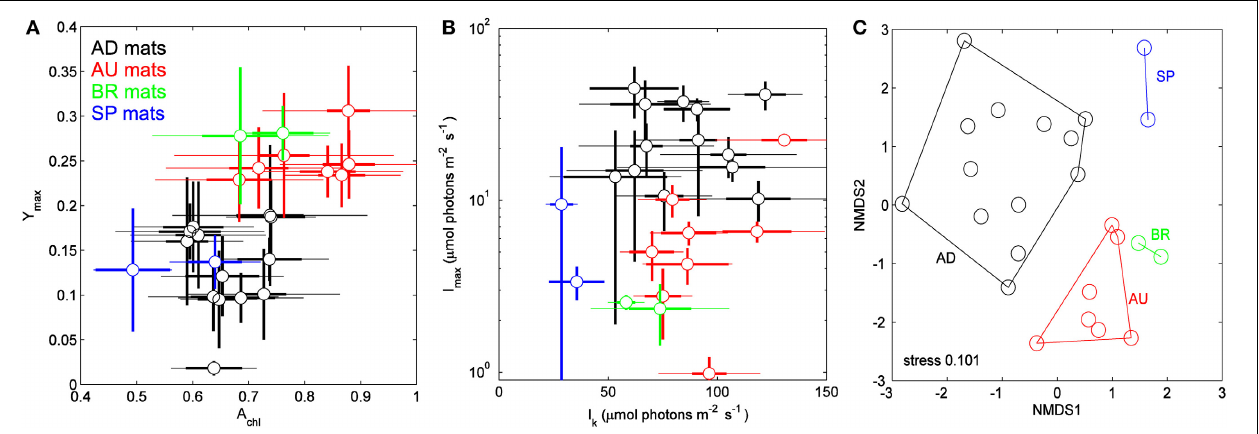
variability (expressed as standard deviation, SD) within the layers, respectively. (C) Multidimensionalscalingplotofthedistancematrixcalculatedbasedonthe average values of the parameters shown in (A,B) using Euclidean